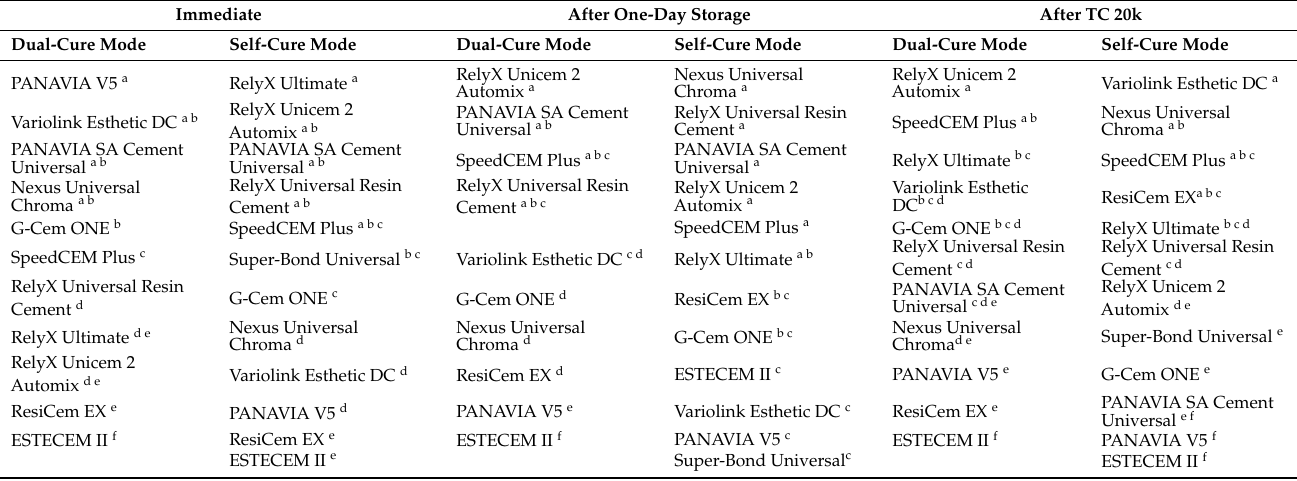
Table 13. Comparison of means (Tukey HSD procedure) for flexural modulus of resin cement material at each time [superscript letters (a–f) represent groups with no significant difference, p > 0.05].